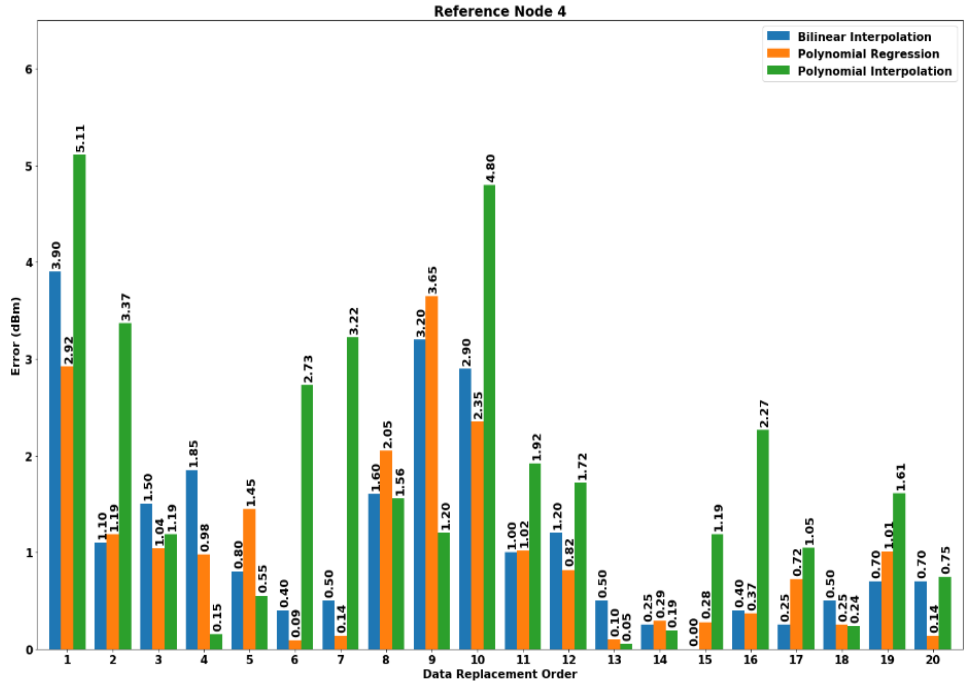
Figure 21. RSSI values error for reference node